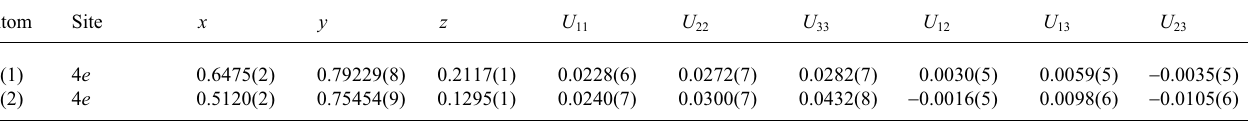
Table 3. Atomic coordinates and displacement parameters (in Å 2